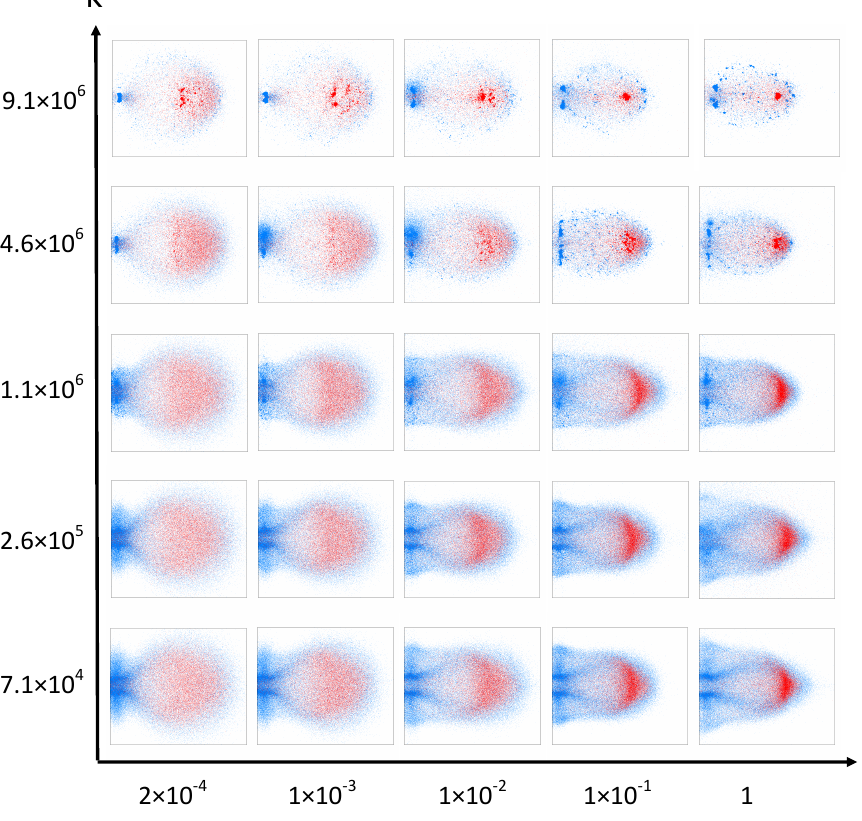
Figure 7. Simulation snapshots of the debris cloud calculated with different values of ε and κ taken at 32 µ s after impact. Impactor particles are shown in red and target particles are shown in